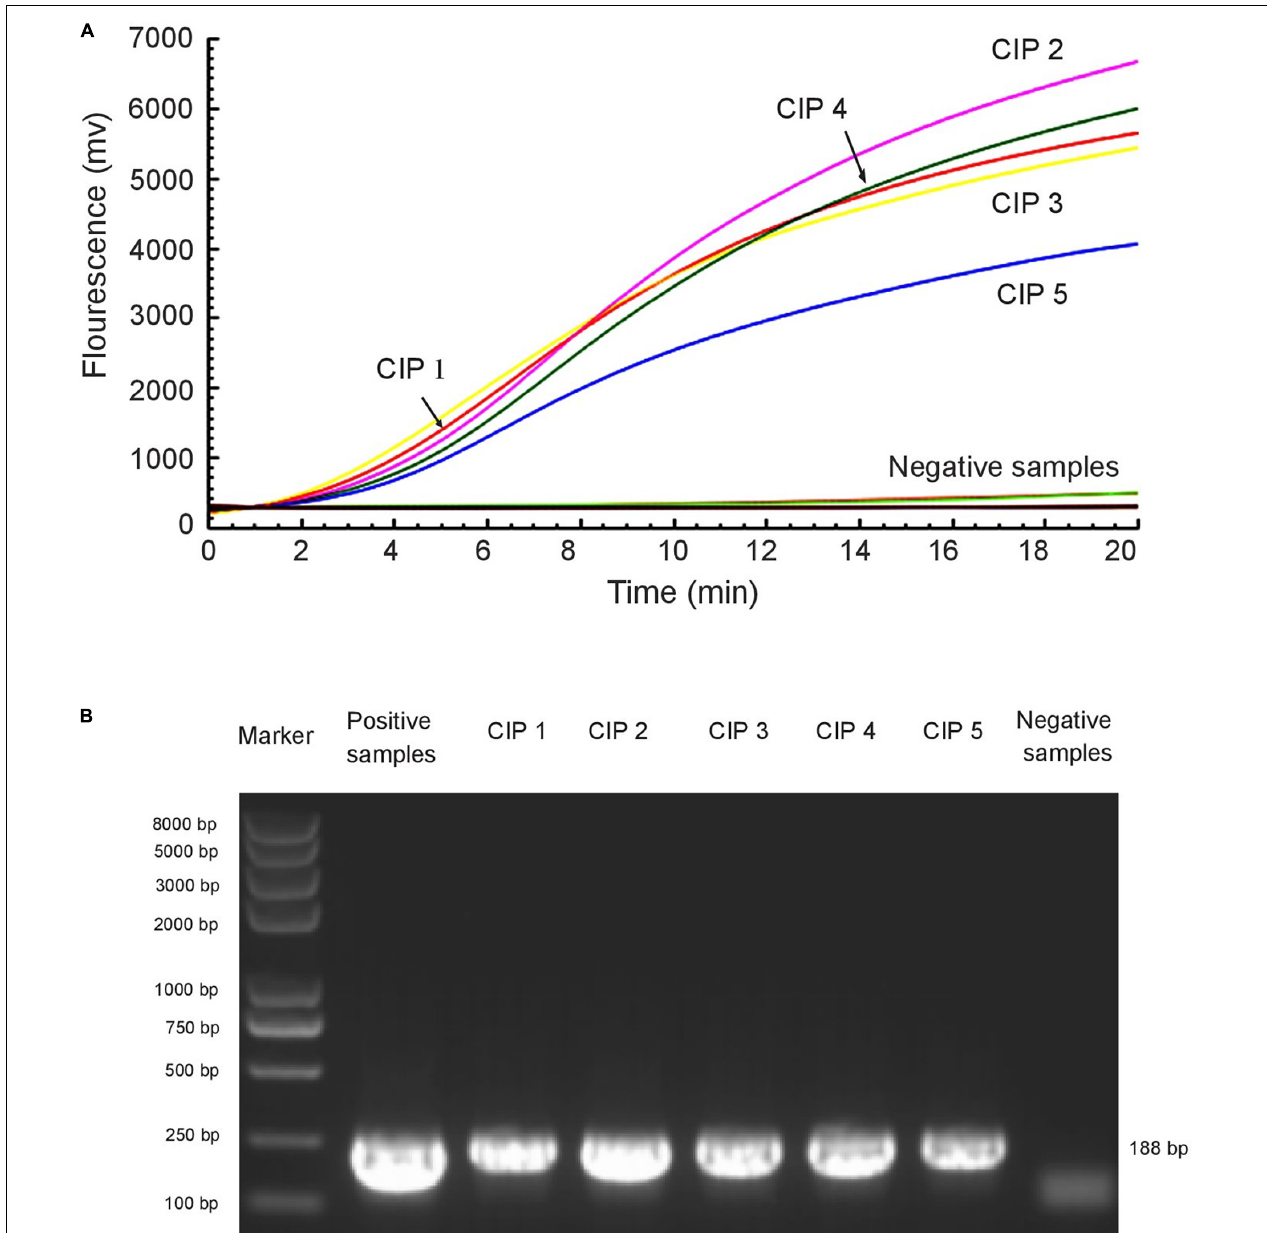
FIGURE 4 | RAA assay was applied to clinical samples. Five mcr -1-positive samples were identified among 672 samples by RAA detection (A) and standard PCR (B) . The E. coli mcr − 1 was used as a positive control and sterile water was used as a negative control.